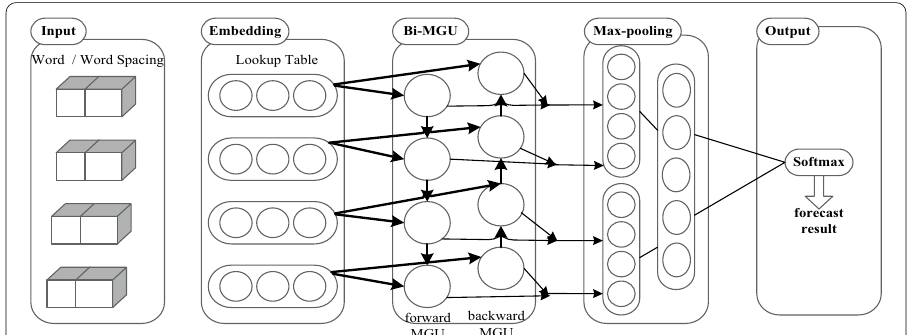
Fig. 1 An illustration on the network structure of the relation